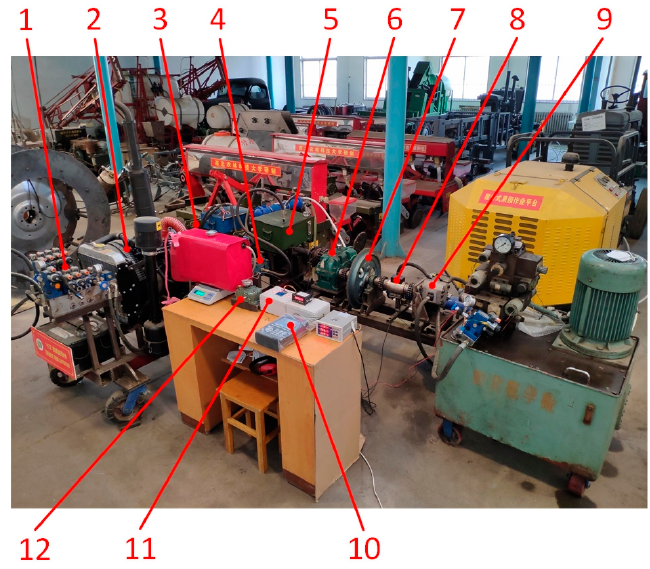
Figure 5. Test bench. 1. Hydraulic control system; 2. Engine; 3. Drive rear axle; 4. HST; 5. Fuel tank; 6. Gear Increaser; 7. Flywheel; 8. Speed & torque sensor; 9. Hydraulic pump; and 10. Data acquisition system 11. Control System. 12. Throttle Adjusting Mechanism.